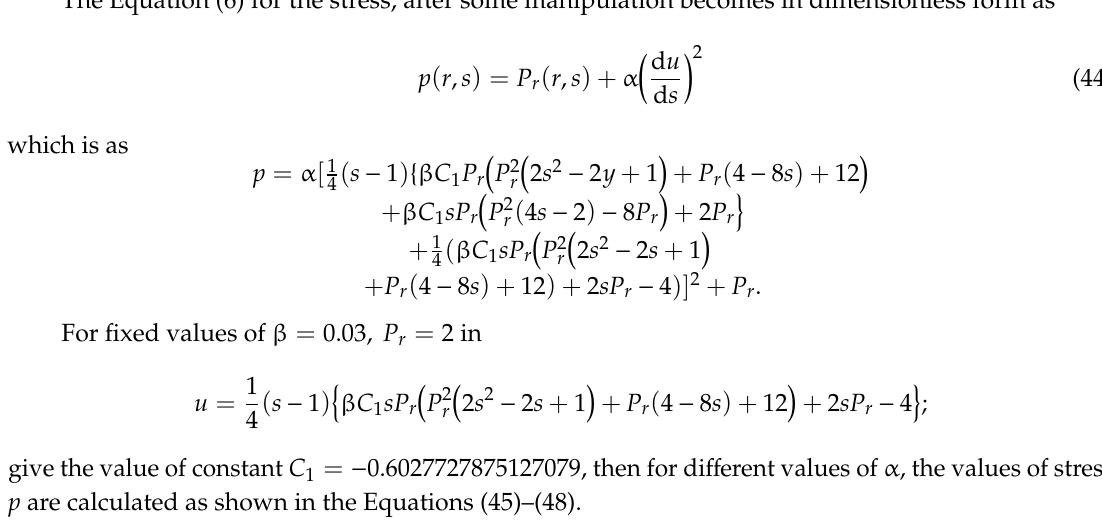
(cid:2914)(cid:3017) Figure 7. 𝑢(𝑠) at different values of and 𝑠 . ( a ) with the s range of [0–2]; ( b ) with the s range of Figure 7. u ( s ) at di ff erent values of d P and s . ( a ) with the s range of [0–2]; ( b ) with the s range of [0–3]; d r (cid:2914)(cid:3045) ( c ) with the s range of [0–7]; ( d ) with the s range of [0–3]; ( c ) with the s range of [0–7]; ( d ) with the s range of [0–12].